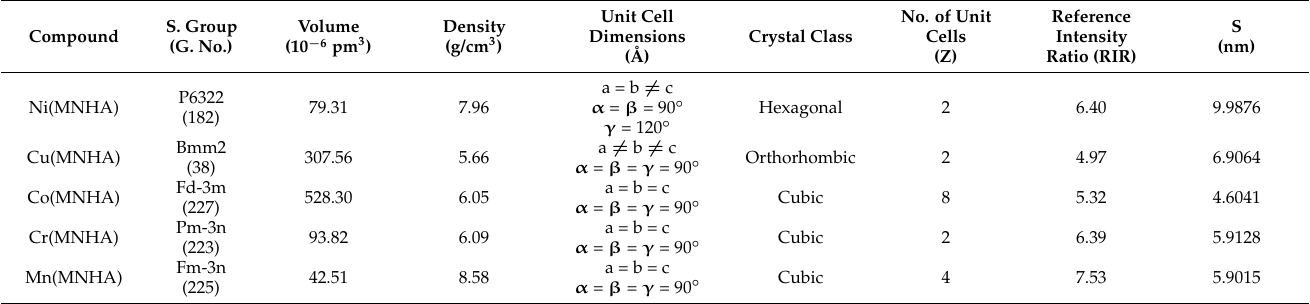
Figure 5. XRD powder diffraction patterns of compounds 4 – 8 . Table 4. Observed refinement parameters and crystallographic data for complexes (compounds 4 – 8